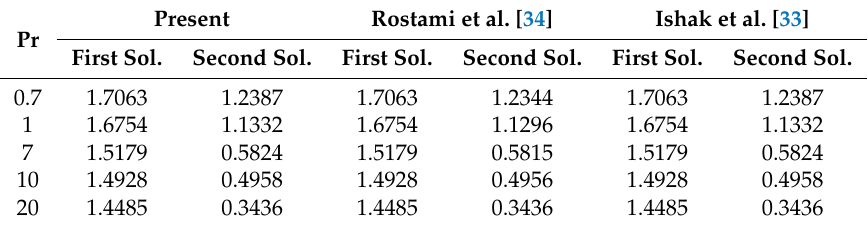
Table 5. f (cid:48)(cid:48) ( 0 ) when φ 1 = φ 2 = Z = d = 0 and λ = 1 for various values of Pr.